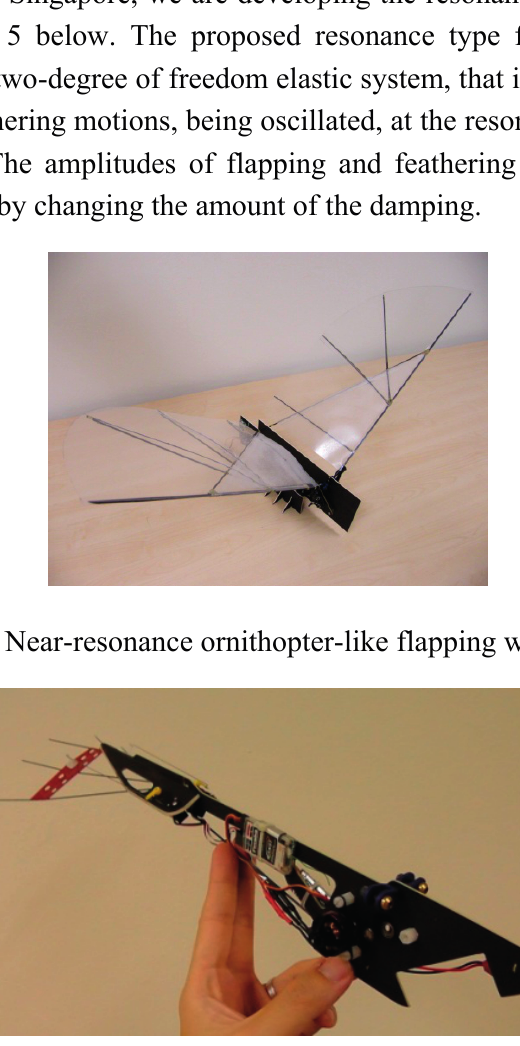
Figure 5. Near-resonance ornithopter-like flapping wing